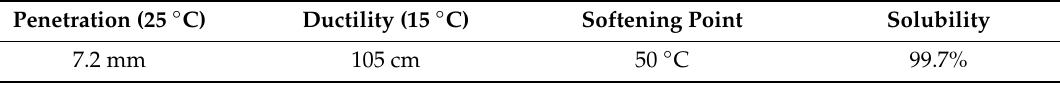
Figure 2. Particle size distribution of the aggregate in the AC-13 and AC-20. Table 1. Properties of 70#